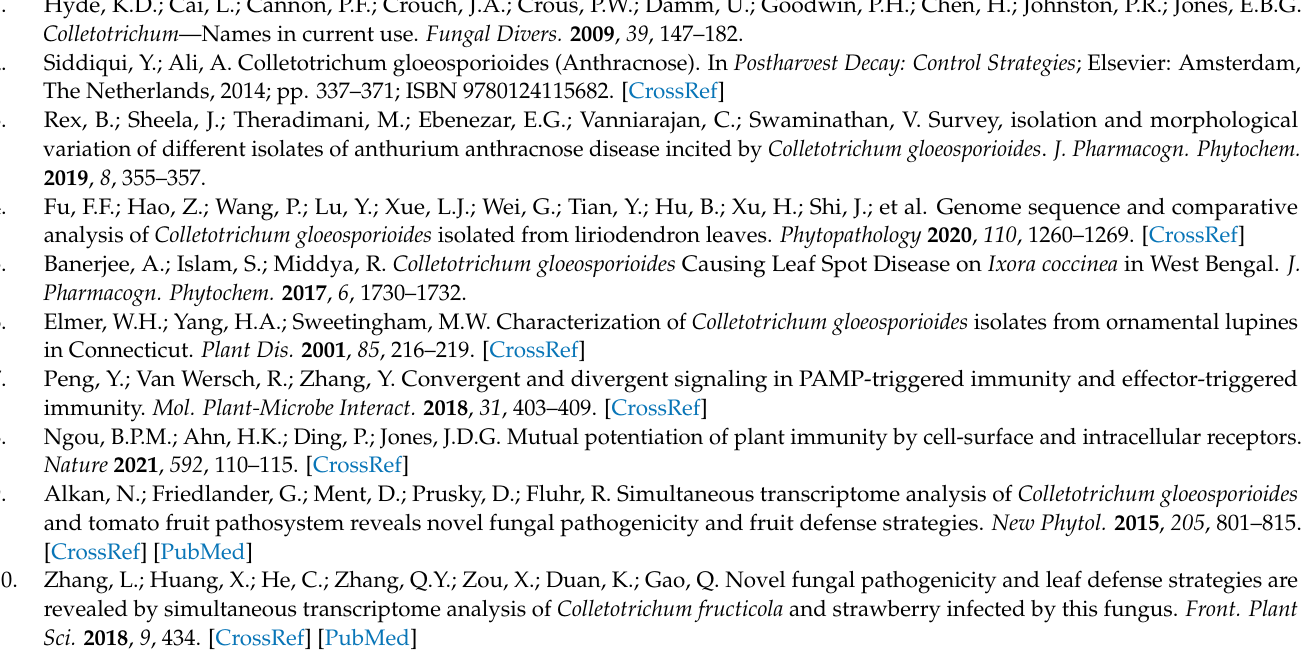
Table S1: Complete list of upregulated genes in Physcomitrium patens during infection by Colletotrichum gloeosporioides . Table S2: Complete list of downregulated genes in Physcomitrium patens during infection by Colletotrichum gloeosporioides . Table S3: Data of upregulated and downregulated genes represented in Figure